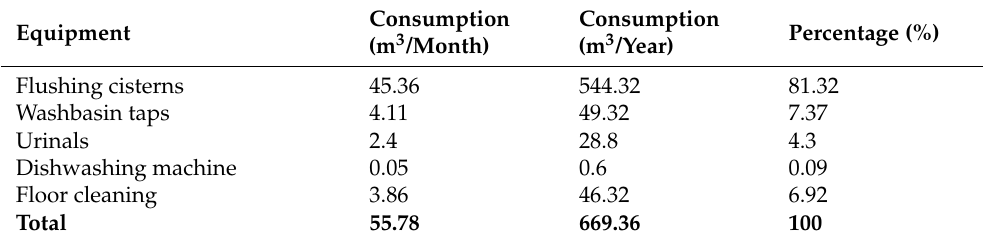
Table 4. Monthly and annual water consumption in the nightclub by use